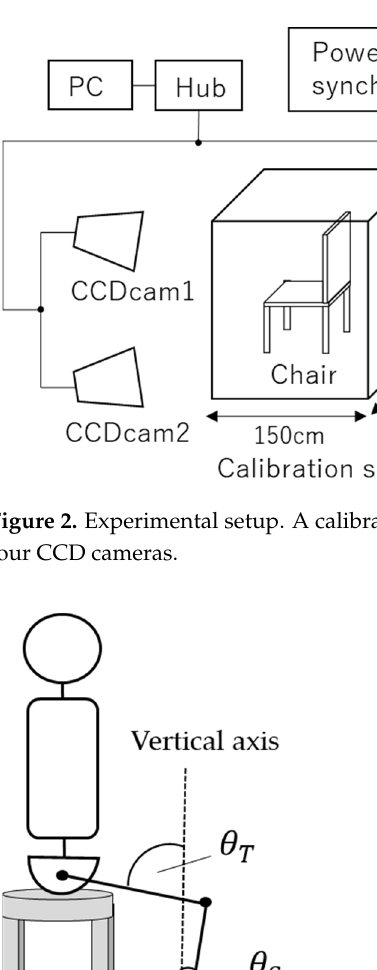
Figure 1. STS measurement experiment. The upper extremity did not touch the body or the outside environment. The plantar was fixed in an arbitrary position that was not interchanged from the beginning to the end of the STS motion. ( a ) The start of the STS motion from the stationary starting posture at the signal, ( b, c ) the STS motion in progress, and ( d ) the end of the STS motion when the ending posture is stationary.